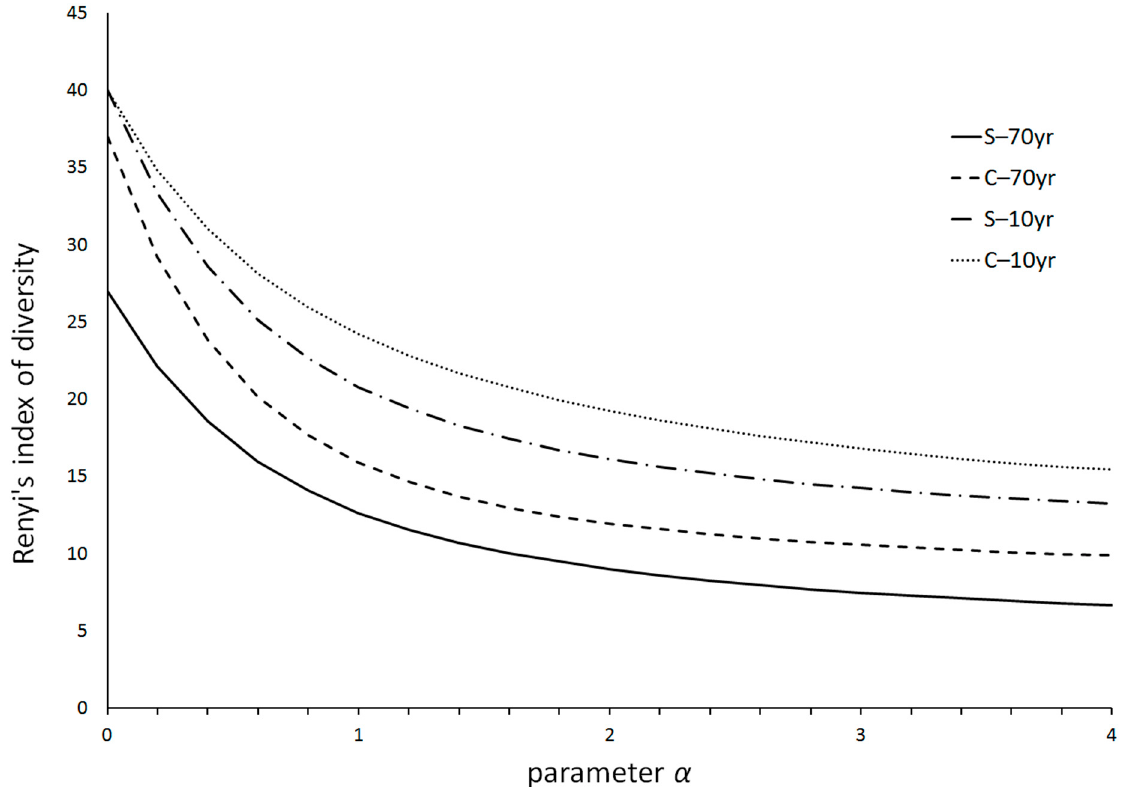
Figure 4. Diversity profiles of nematode communities in the rhizospheres of the alien Solanum elaeagnifolium (S) and the native Cichorium intybus (C) in recently (10 yr) and historically (70 yr) invaded sites.